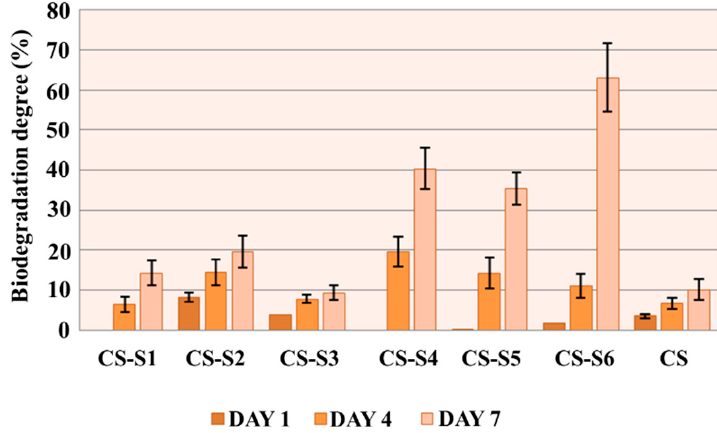
Figure 7. In vitro biodegradation of chitosan-derivative films.